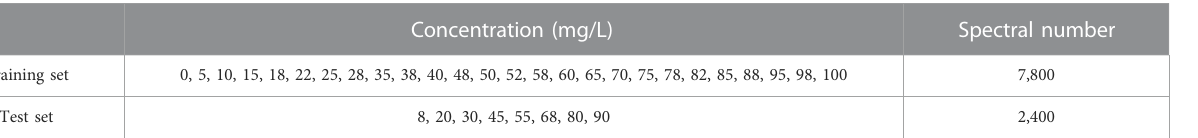
TABLE 3 COD solution sample